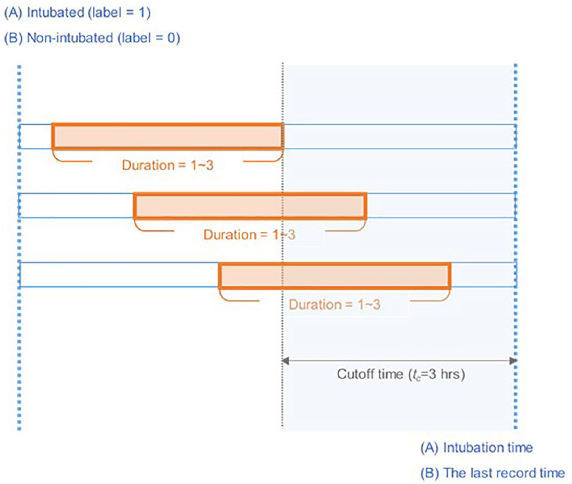
Figure 1. Detailed illustration of dataset generation. The records for individual patients were divided into training and test dataset, and intubated and non-intubated patients were labeled 1 and 0, respectively. Multiple samples were extracted with a random duration (1–3 h) containing the cutoff time ( t c ), which corresponded to the fixed time before the intubation time or last record